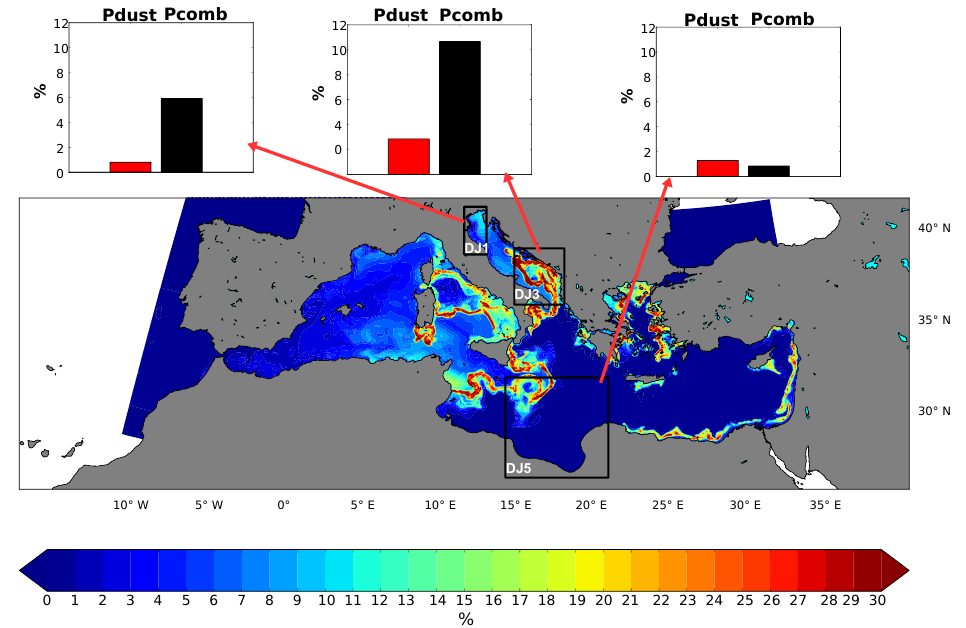
Figure 11. Map of maximal relative effects of total (Pdust + Pcomb) deposition on primary production in the surface Mediterranean (0– 10m) in June 2005 (on a daily basis). The reference primary production concentration values are taken from the REF simulation without atmospheric phosphate deposition. Bar plots represent average relative effects of each source (%) within the framed areas excluding land. The limits of the areas are described in Manca et al. (2004). There is no atmospheric deposition modeled in the Marmara and Black